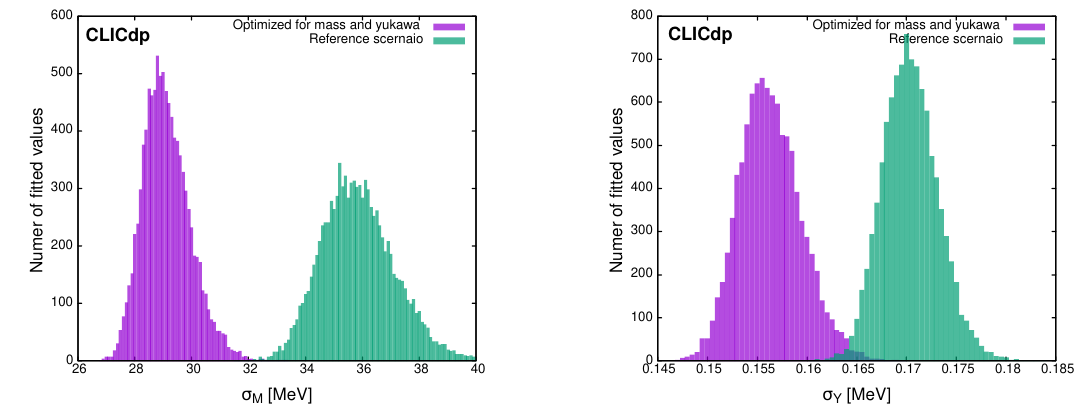
Figure 15 . Uncertainty distribution for mass (left) and Yukawa coupling (right) measurement, for 8 point scan scenario optimised for mass and Yukawa coupling measurement (see figure 13), compared with the distributions for the reference